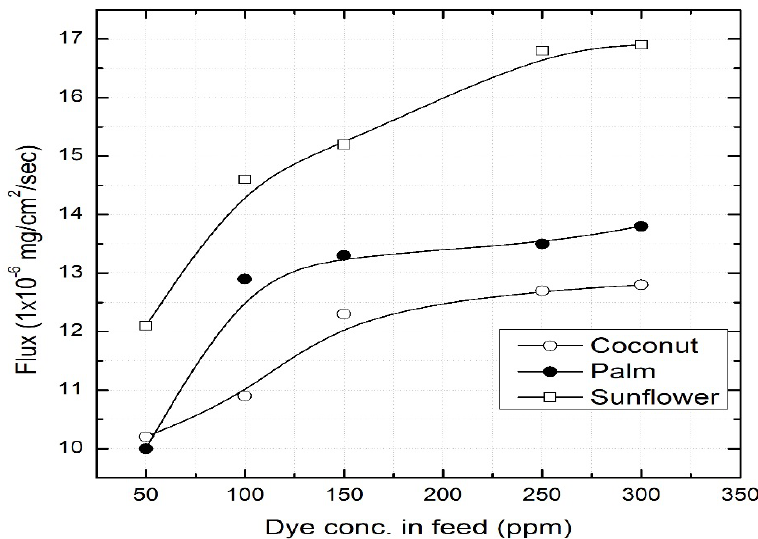
Figure 4. Effect of dye concentration in the feed chamber. Feed = 50–350 mg/L at pH 11; stripping chamber = 0.25 M HCl; permeation time = 8 h.